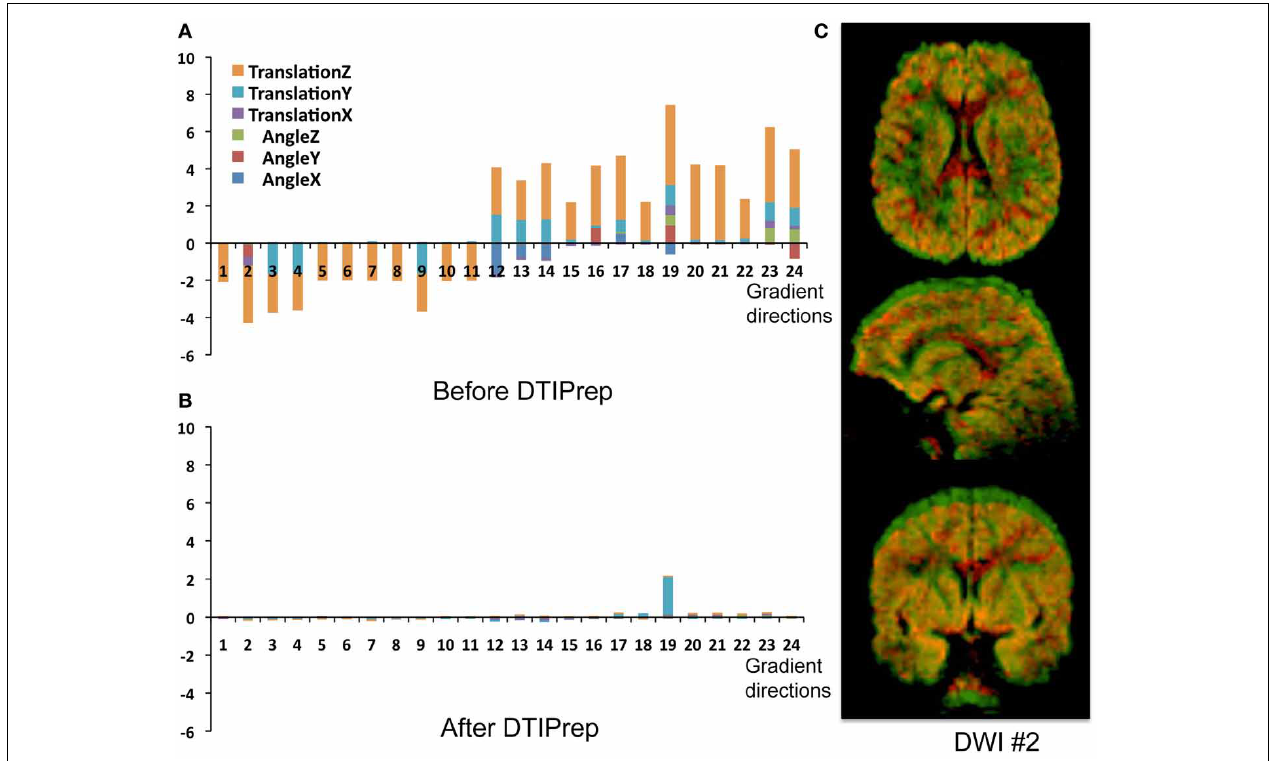
FIGURE 2 | Head-motion artifacts. Rigid registration parameters between each gradient and baseline image of the original DWIs (A) and corrected DWIs (B) . (C) Overlay comparison between original DWI #2 before (red) and after (green) correction.